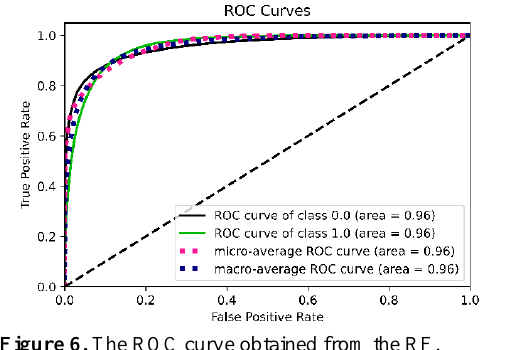
Figure 6. The ROC curve obtained from the RF.